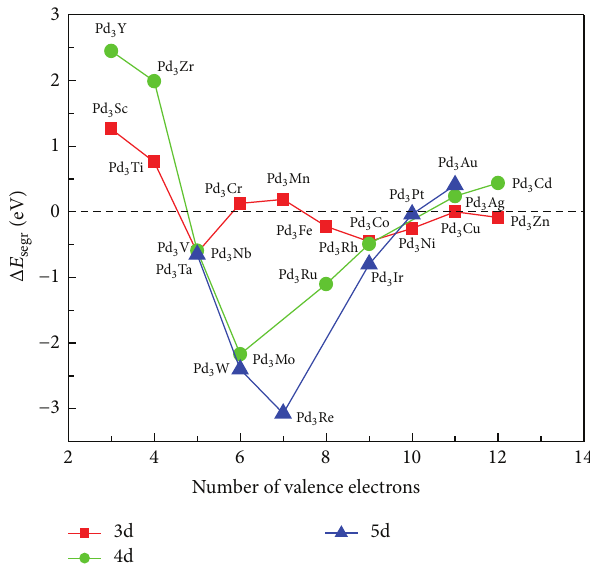
Figure 2: The relationship between the calculated segregation ) of Pd 3 M alloys and number of valence electrons. energy ( Δ𝐸 segr